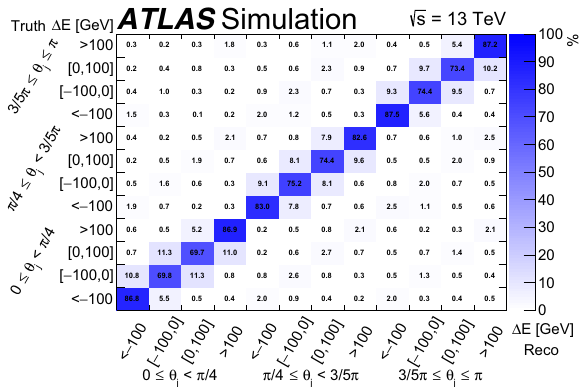
Fig. 4 Migration matrix, normalised to 100% in each truth bin. This gives the probability of a reconstructed event created in truth bin j to be reconstructed in bin